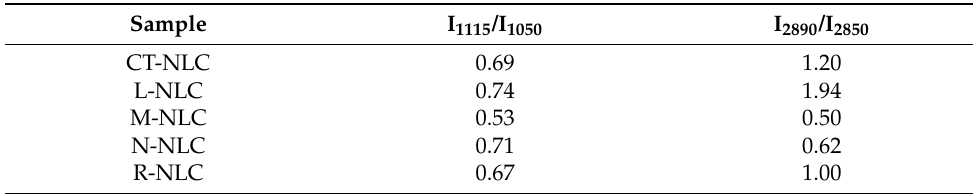
Table 4. Raman intensity ratios related to C-C stretching vibrational bands (I 1115 /I 1050 ) and C-H stretching vibrational bands I 2890 /I 2850